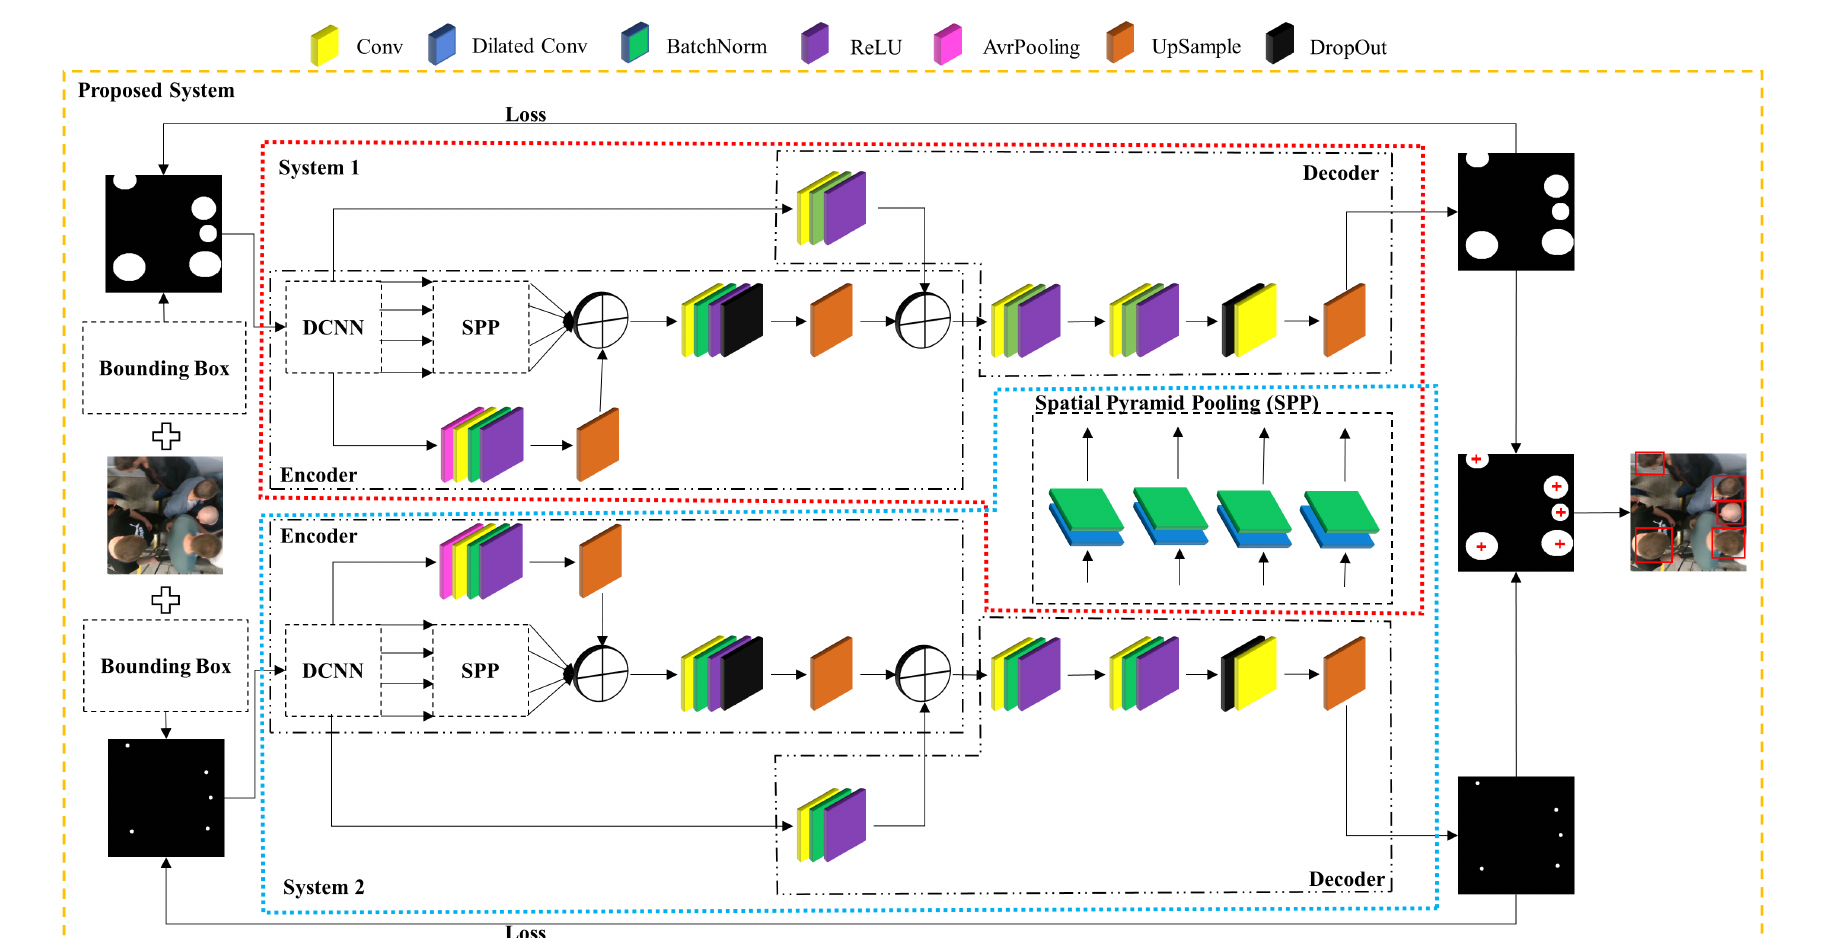
Figure 2. Block diagram describing the architecture of the proposed merged system for the detection of the human